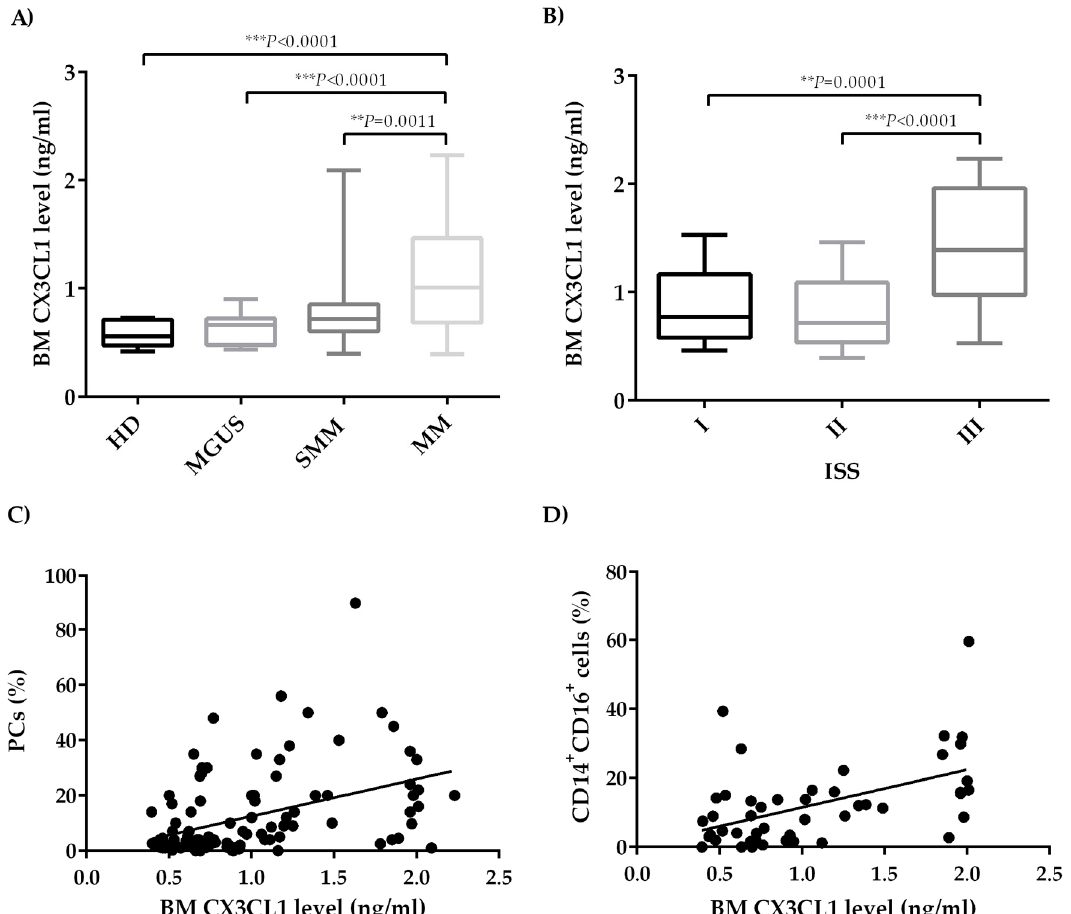
Figure 1. BM levels of CX3CL1 in patients with monoclonal gammopathies. ( A ) Box plots represent the median levels of CX3CL1 (ng/ml) evaluated in BM plasma obtained from patients with MGUS (n = 16), SMM (n = 25), MM (n = 70), and HD (n = 10) ( P value calculated by Mann–Whitney test). ( B ) Box plots represent the median levels of BM CX3CL1 in patients with active MM grouped by the ISS stage I (n = 17), II (n = 20), and III (n = 33) ( P value calculated by Mann–Whitney test). ( C ) Scatter plots showing the correlation between CX3CL1 BM plasma levels and percentage of BM PCs obtained from the BM aspirate of 105 patients with monoclonal gammopathies by flow-cytometry analysis (*** P < 0.0001, r = 0.44 calculated by Spearman’s correlation). ( D ) Scatter plots show a significant positive correlation between CX3CL1 levels in BM plasma obtained from 48 patients with monoclonal gammopathies and percentage of CD14 + CD16 + monocytes evaluated by flow cytometry (** P = 0.0006, r = 0.48 calculated by Spearman’s correlation). CX3CL1—C-X3-C motif chemokine ligand 1; MUGS—